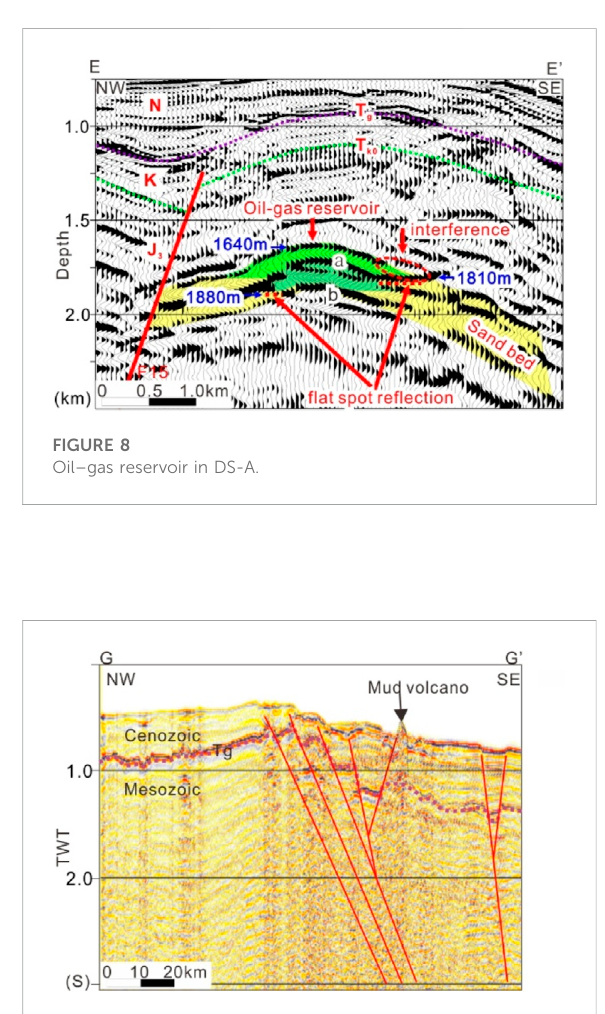
FIGURE 9 Mud volcano nearby DS-A (by courtesy of Yan et al.